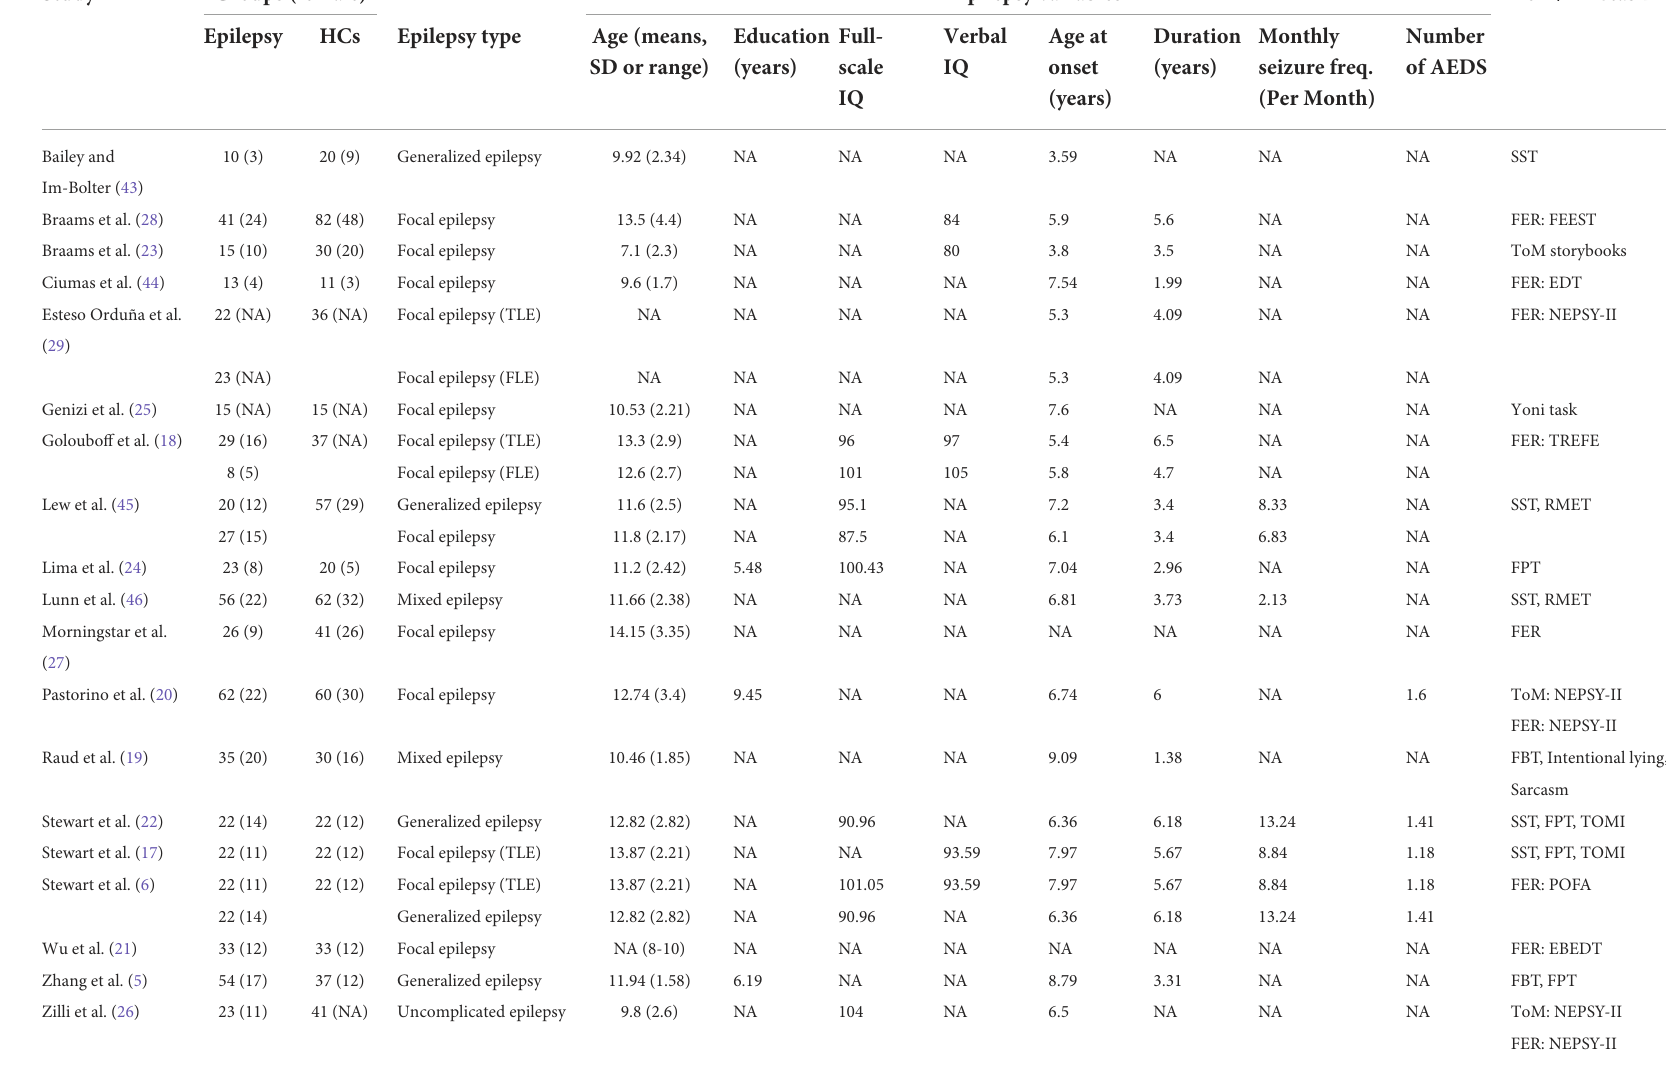
TABLE 1 Characteristics and patient demographics of studies included in the